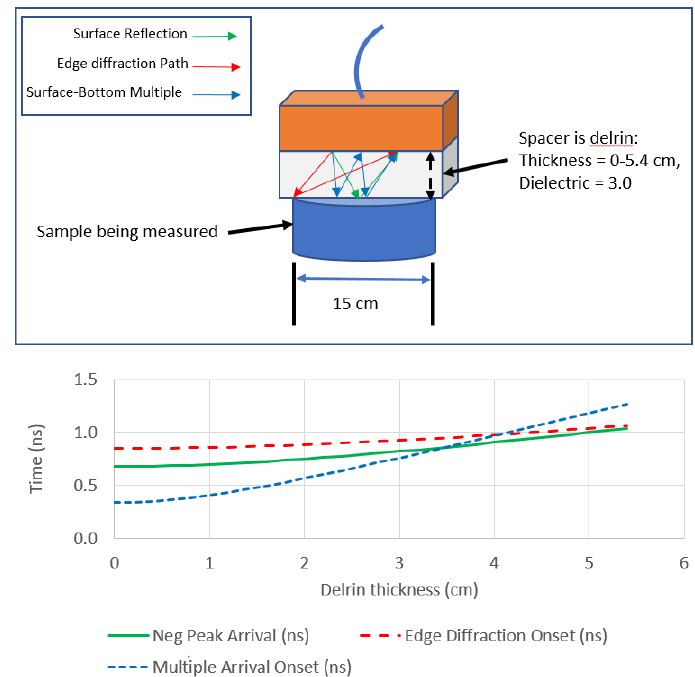
Figure 8. Calculations of the arrival time of the negative peak of the surface reflection versus the start of the edge diffraction and multiple reflection arrival times for 3.0 dielectric material, of varying thicknesses.